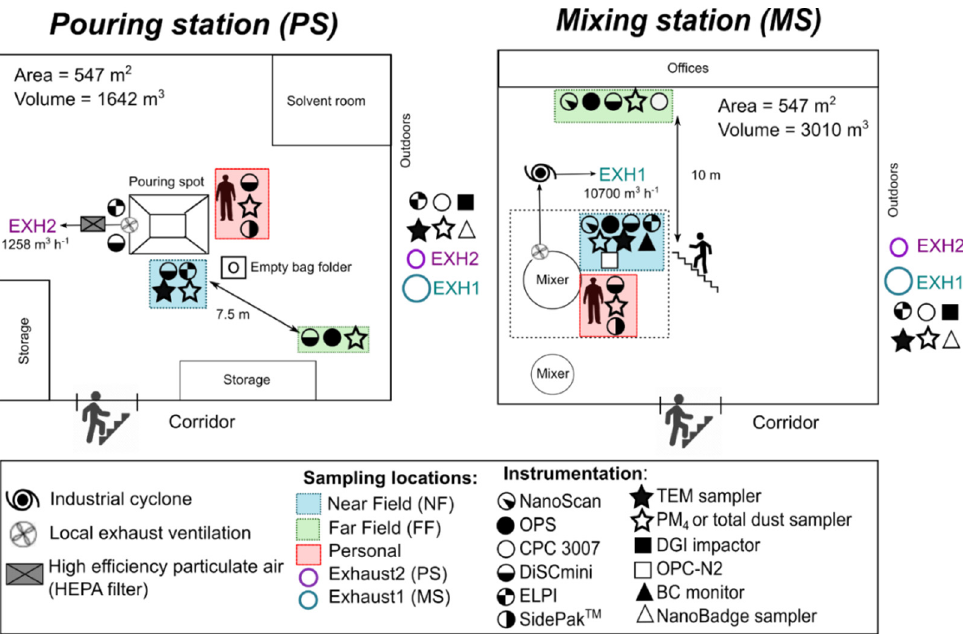
Figure 1. Layout of the working environment and location of instrumentation and samples. Particles in the breathing zone (BZ) were measured with the personal measurement instruments attached in a carry bag to the worker’s shoulder. At the stationary NF measure- ment points in PS and MS the inlets of the instruments and the samplers were approximately at a height of 1.5 m and 0.5 m from the powder pouring activities. Therefore, the NF was defined as the volume around the process activity where the worker stands during the work process. At the stationary FF measurement points, the instruments and samplers were placed from 7.5 to 10 m from the NF locations (Figure